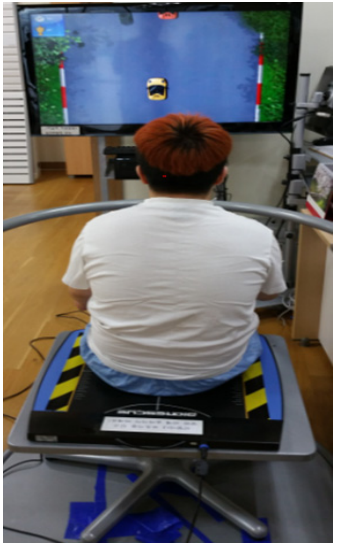
Figure 1. BioRescue